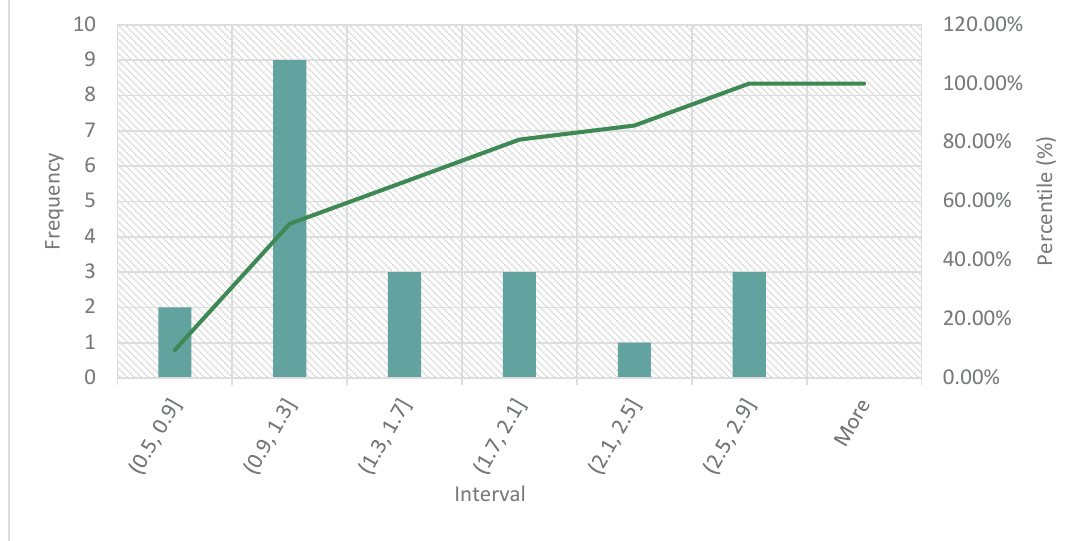
Fig. 3: Histogram and Pareto Graphic for Secchi Disk in Osceola County